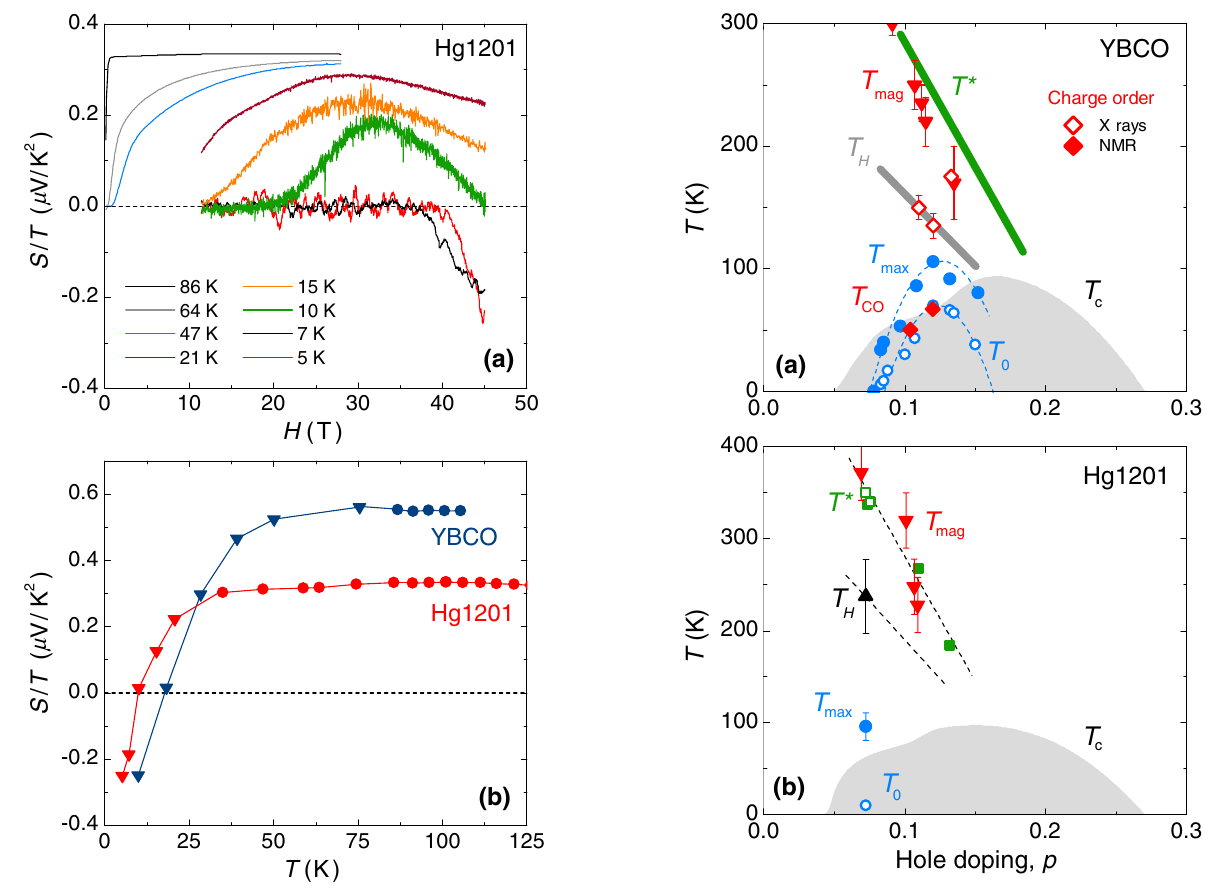
FIG. 2. (a) Seebeck coefficient S of Hg1201 plotted as S=T versus H , in sample A at various temperatures, as indicated. (b) Normal-state Seebeck coefficient S=T of Hg1201 as a function of temperature, at H ¼ 28 T (red circles) and H ¼ 45 T (red triangles). Corresponding data are shown for YBCO at p ¼ 0 : 10 in H ¼ 0 (blue circles) and 28 T (blue triangles), from Ref. [8].